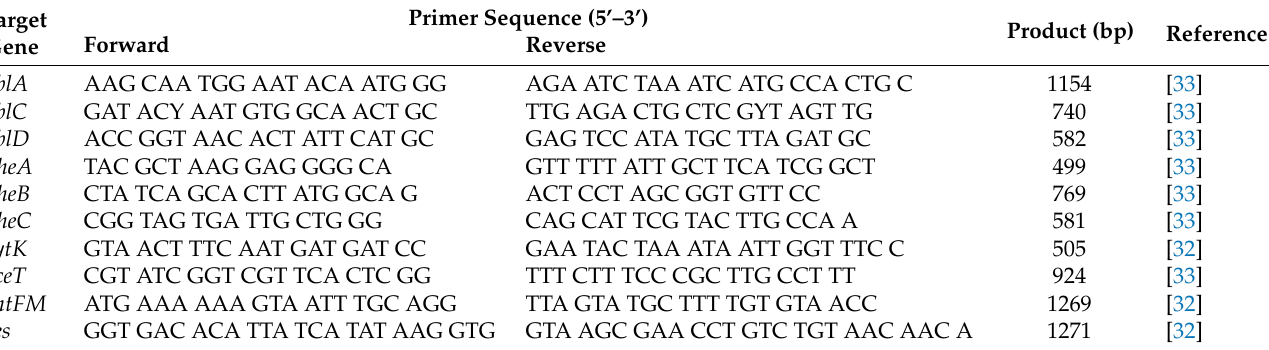
Table 1. Sequences of primer sets used in this